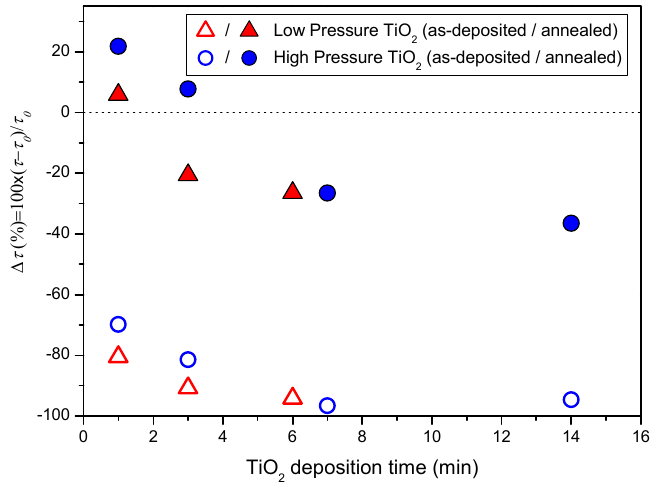
Figure 5. Relative change in effective minority carrier lifetime, τ eff , with respect to the value τ 0 measured before TiO 2 deposition, obtained in SHJ precursors with different TiO 2 film thickness deposited at low pressure (red triangles) and high pressure (blue circles). Open symbols correspond to the data measured in as-deposited films, while closed symbols represent the data obtained after annealing the samples in a hot plate at 200 ◦ C for 10 min.